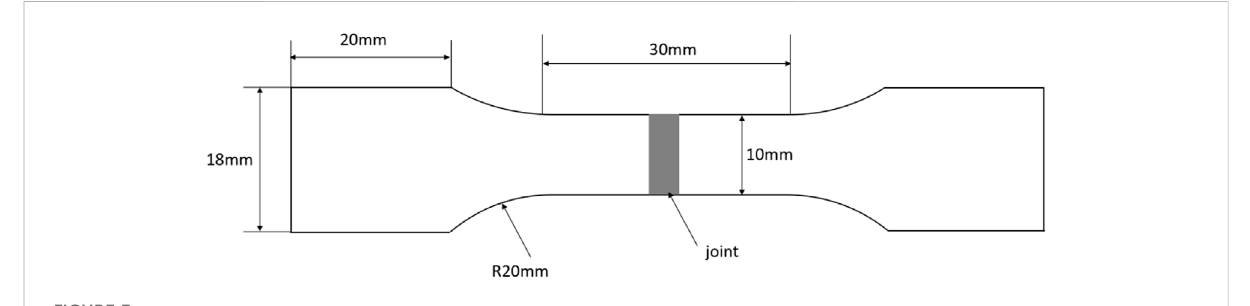
FIGURE 3 Sketch map of the tensile testing